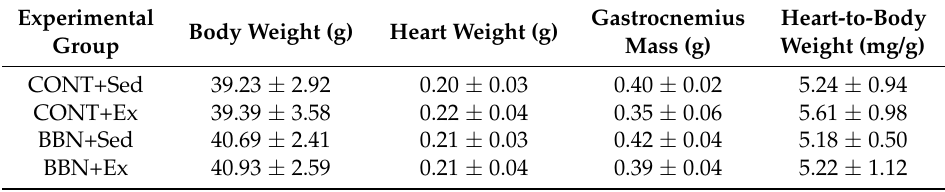
Table 1. Characterization of the animals’ response to N -butyl- N -(4-hydroxybutyl) nitrosamine (BBN) and/or exercise training regarding body weight, heart mass, muscle mass, and heart-to-body weight. Experimental